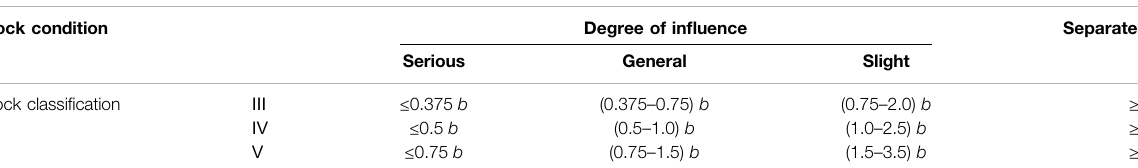
TABLE 1 | Division of interaction degree between two neighborhood tunnels.